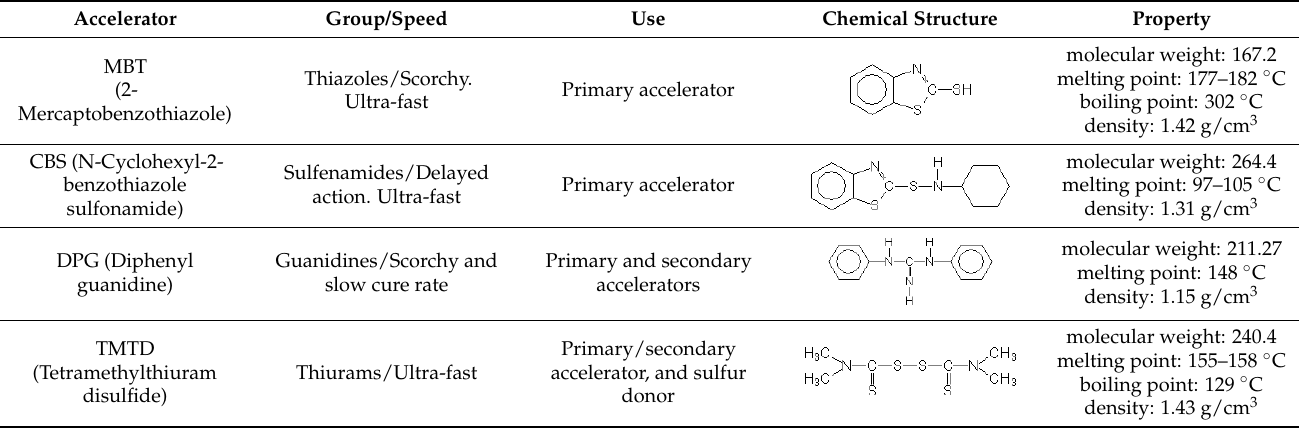
Table 1. Physical and chemical characteristics of the vulcanization accelerators.